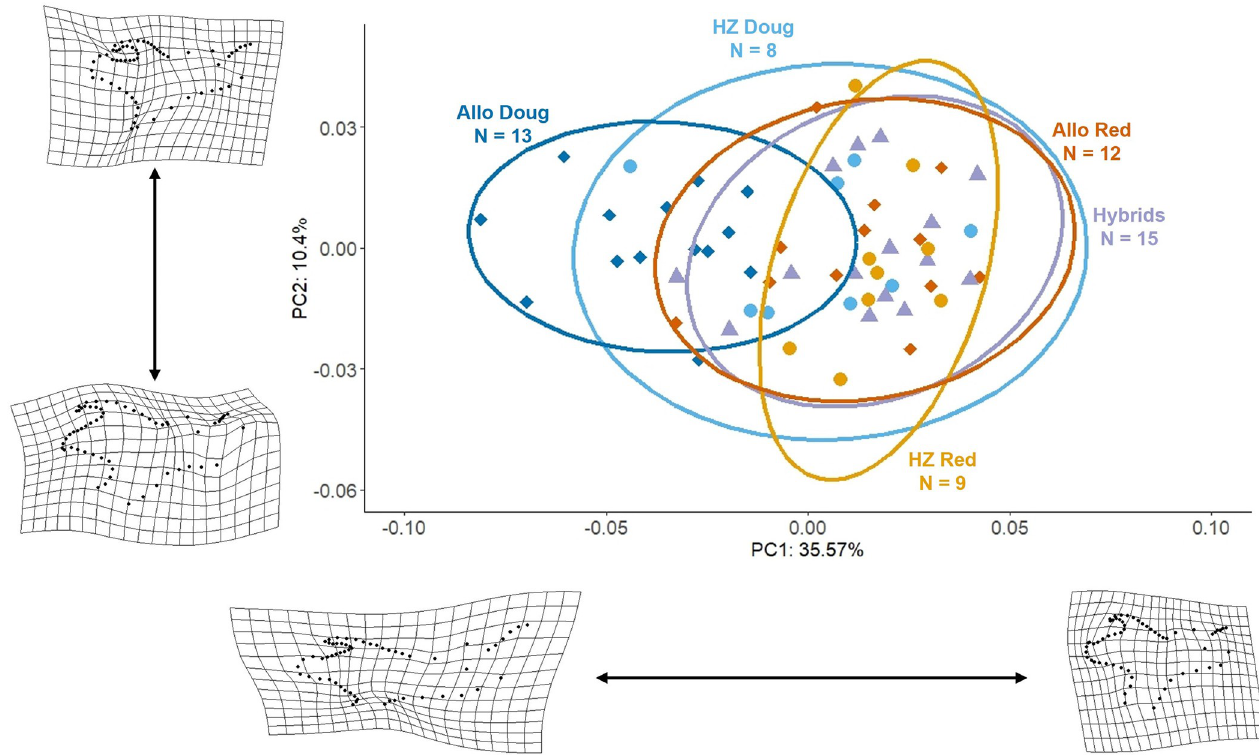
Fig 4. Principal component analysis of mandible shape in lateral view. Deformation grids for principal component axes accompany their respective axis and were based on the graphed extremes for the figure. Abbreviations are provided in Fig 2. https://doi.org/10.1371/journal.pone.0284094.g004 (Table 1; p = 0.001, F = 5.19) and the interaction between group and centroid size 1,46 (p = 0.007, F = 2.38); but mandible shape was not significantly affected by sex (p = 0.264, 4,46 F = 0.61) or interactions between sex and size (p = 0.166, F = 0.99). The ANOVA of cen- 1,46 1,46 troid size demonstrated a significant difference in size among the different squirrel groups (Fig 5; p < 0.001, F = 22.94). Post-hoc comparisons indicate significant differences in centroid 4,53 size between allopatric red squirrels and allopatric Douglas squirrels (p < 0.0001), as well as between hybrid-zone red squirrels and hybrid-zone Douglas squirrels (p = 0.0011). In addi- tion, hybrid-zone Douglas squirrels are significantly larger than allopatric Douglas squirrels (p < 0.0001). There are no significant differences between hybrid-zone red squirrels and allo- patric red squirrels (p = 0.498). Hybrids are significantly larger than hybrid-zone Douglas Table 1. Procrustes ANOVA of lateral view mandible shape data. Relationships assessed were for squirrel group, sex, log transformed centroid size, and the interactions size by group and size by sex. Significant p-values are shown in bold.